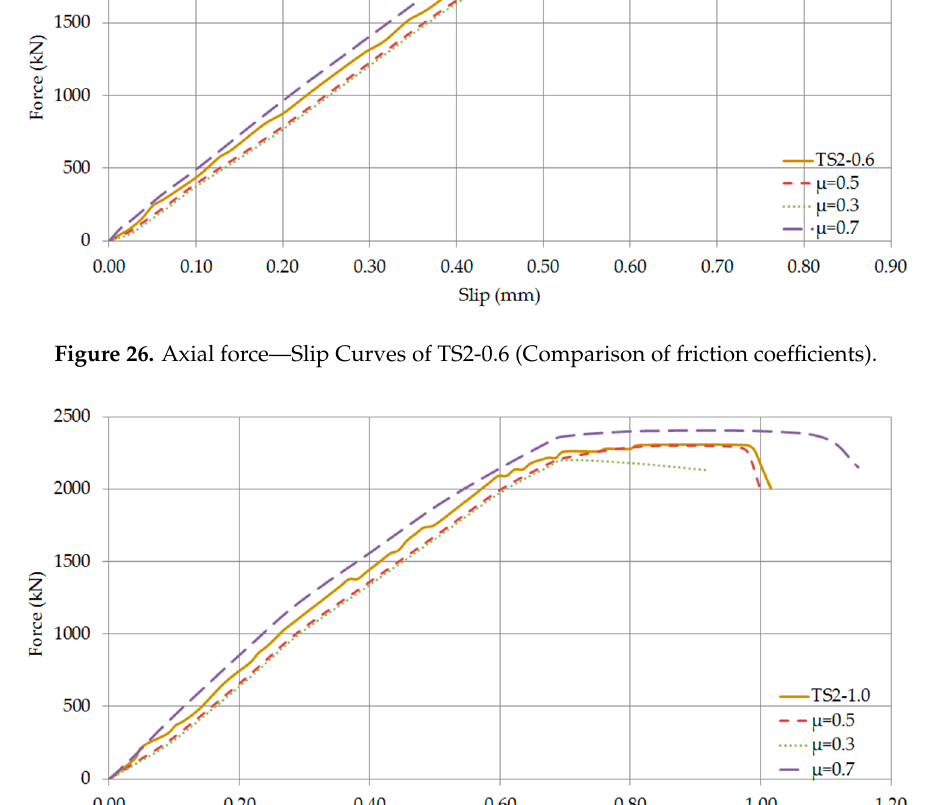
Figure 27. Axial force—Slip Curves of TS2-1.0 (Comparison of friction coefficients).